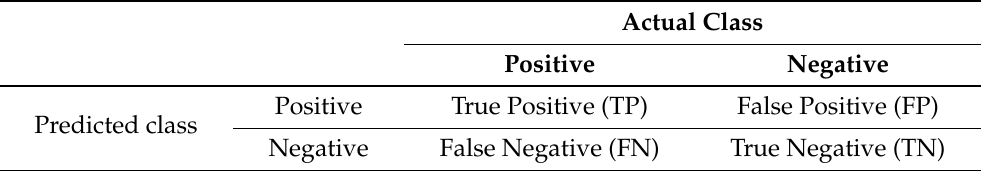
Table 2. Confusion matrix used to form evaluation metrics.